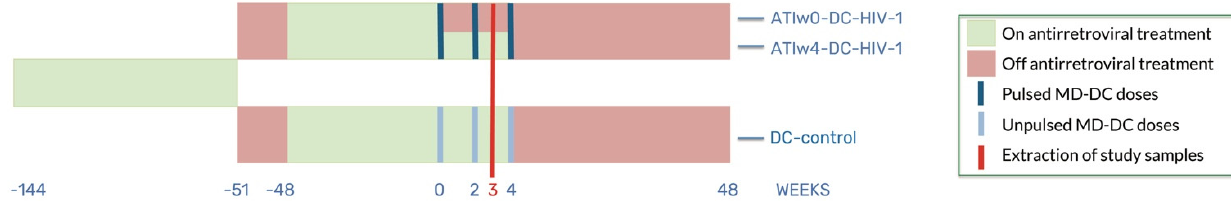
Figure 1. Protocol outline of the DCV2 trial and the time of extraction of the samples for the present study. Patients in the DC-HIV-1 groups received three doses of dendritic cells pulsed with heat-inactivated autologous HIV-1 virions at weeks 0, 2 and 4, and patients in the DC-control group received unpulsed dendritic cells. Half of the patients in the DC-HIV-1 group stopped antiretroviral treatment at receiving the first vaccine dose (ATIw0-DC-HIV-1) while the other half (ATIw4-DC-HIV-1) and the DC-control arm continued treatment until the last vaccination. Samples for the present study were collected at week 3.